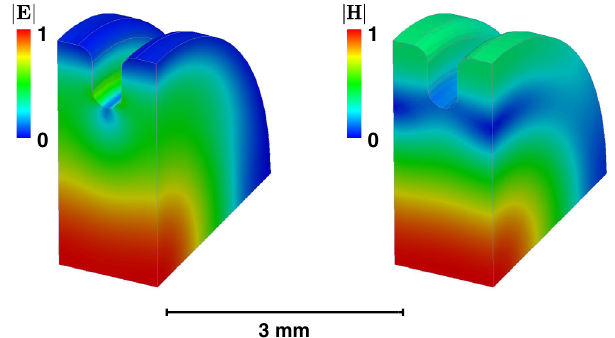
FIG. 3. Surface electric and magnetic field of one quarter of a corrugated waveguide unit cell, adapted from Toufexis et al.